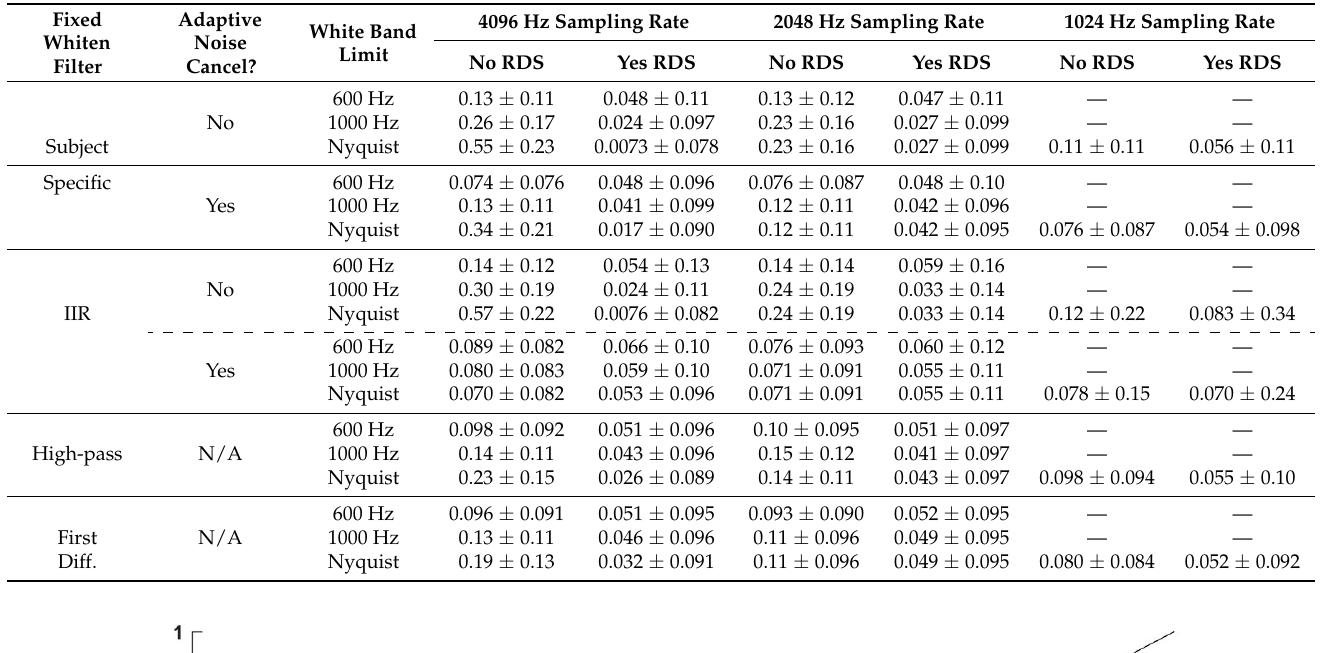
Table 2. Mean ± std. deviations of ratios of 0 % to 50% EMG σ for different fixed whitening filter methods ( N = 64 subjects). Smaller ratios denote better performance. Table 3. Study 2 whitening method statistical results: this table lists non-significant paired comparisons between whitening methods after fixing the sampling rate and whitening band limit (RDS processing used). ANC = adaptive noise canceling. Sampling rate = f c .